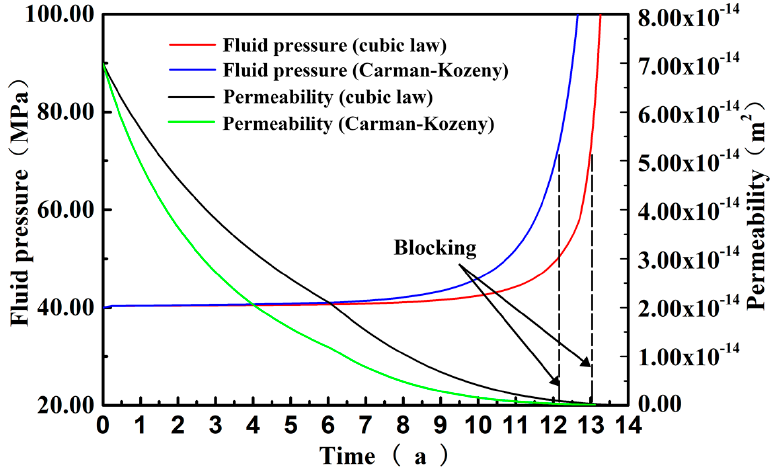
Figure 8. Changes in the permeability and pressure at the injection grid.